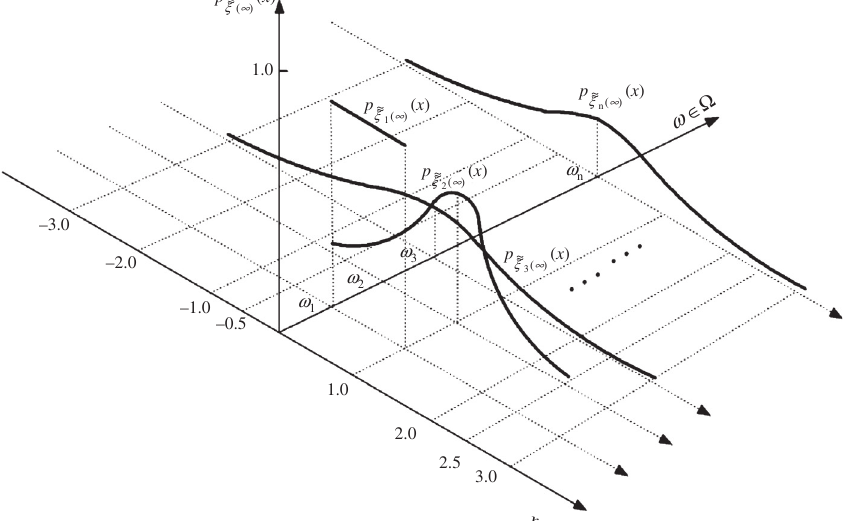
Fig. 7. Representation of a birandom variable in Example